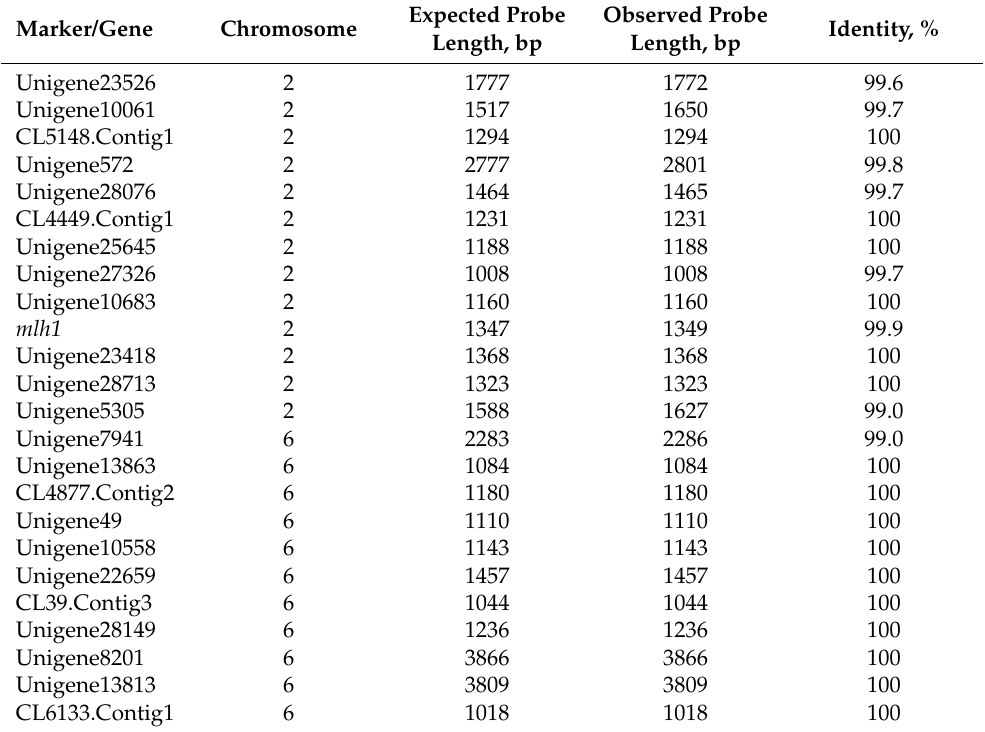
Table 1. Comparison of the expected and observed probe lengths, including the identity of alignments between probe and genomic